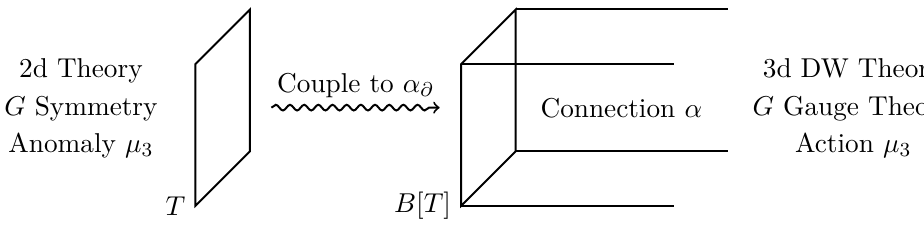
Figure 1 . We take a 2d theory with G symmetry and anomaly µ 3 and use it to produce a boundary condition for the dynamical 3d DW theory with gauge group G and action µ the 2d theory is cancelled by anomaly inflow from the bulk 3d theory. This picture can also be understood in terms of a boundary state as depicted in Equation